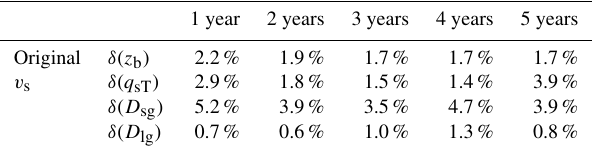
Table 5. Quantification of the difference between predictions of the flux form and the entrainment form in the case of sediment mix- tures. The maximum δ values in the calculational domain are pre- sented for 5